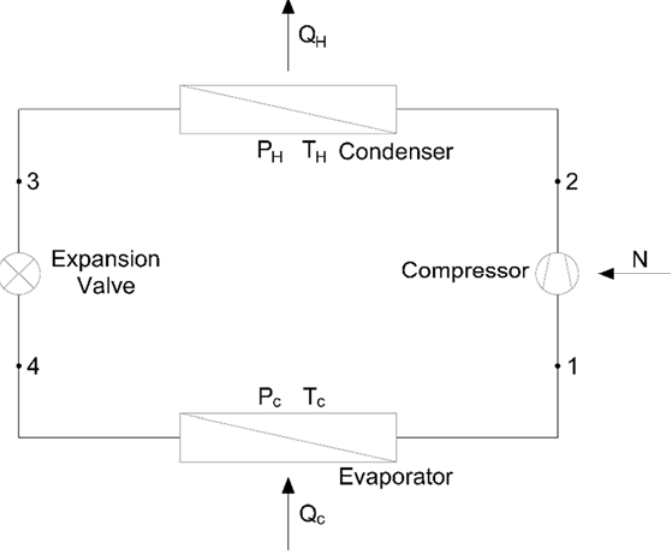
Figure 3. Schematics of the vapour ‐ compression device. Reprinted with permission from ref. [19]. 2017 Duarte et al.